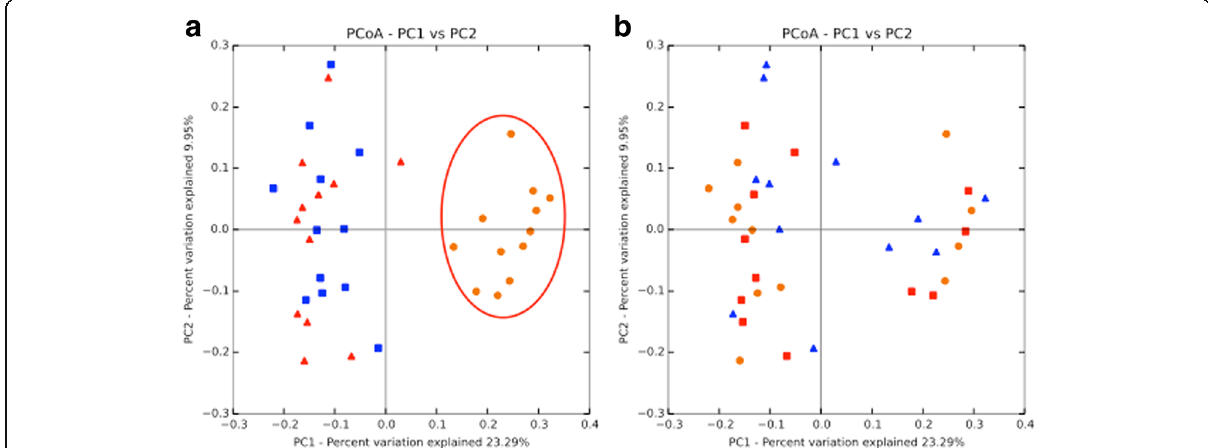
Fig. 6 PCoA plots of unweighted UniFrac distance matrix. PC1/PC2 score plot showing the distribution of samples. The same plots are shown in each panel, with symbols referring to individual samples, but colour coding of each sample refers to time points in a (t0 = red triangles, t15 = blue squares, t105 = orange circles) or treatment type in b (CTRL = red triangles, LGG = blue squares, MBC = orange circles). The percentage variation explained by the plotted principal coordinates is indicated in the axis legend. Score values shown along the axes represent the proportion of dissimilarities captured by each